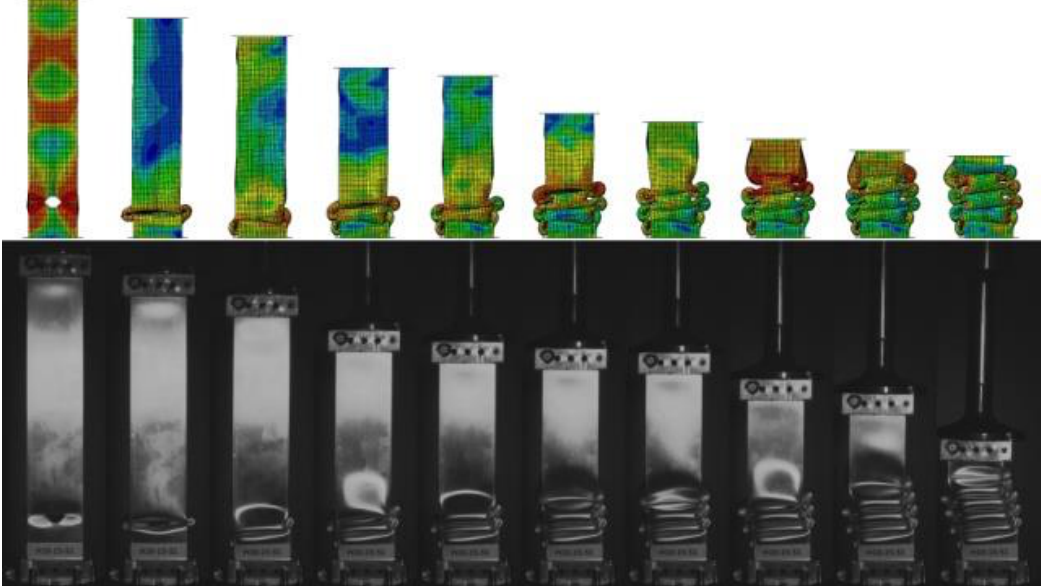
Figure 9. Comparison of numerical and experimental force-shortening characteristics.